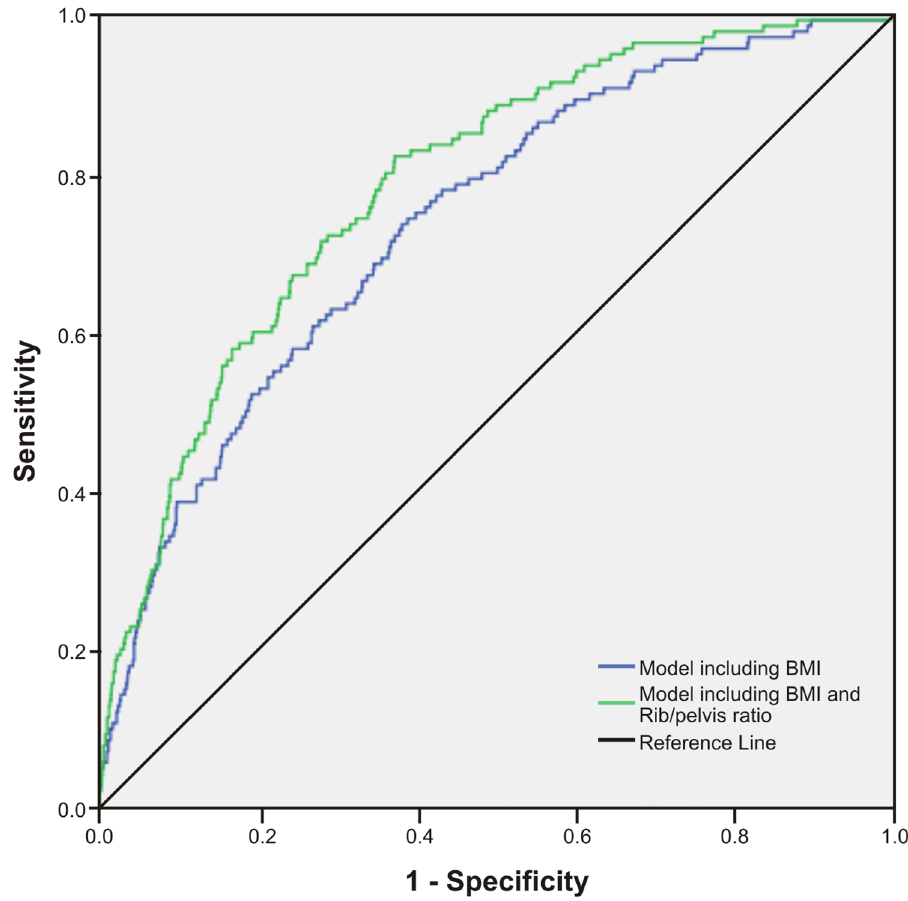
Fig 9. Receiver operating characteristic curves for prediction models to discriminate subjects with type 2 diabetes. Figures show ROC curves for a model including BMI and a model including BMI and Rib/ pelvis ratio. All models include age and